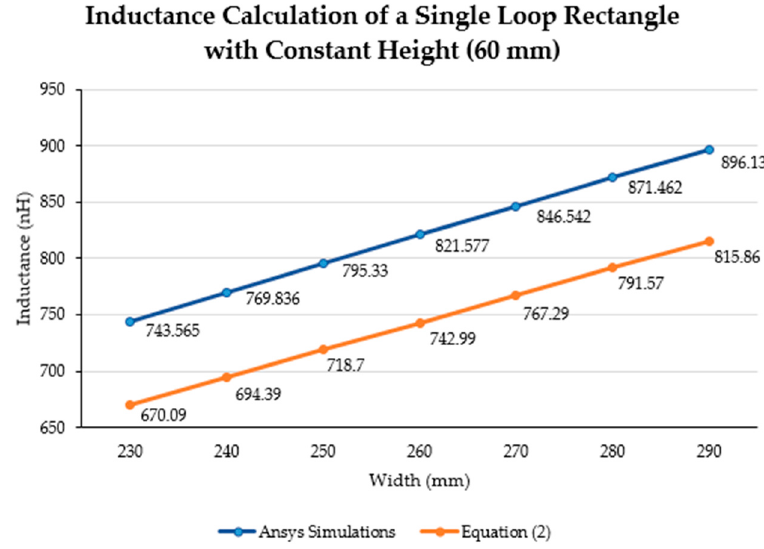
Figure 16. Inductance calculation (nH) using Equation (2) and Ansys simulations with a constant height (60 mm).